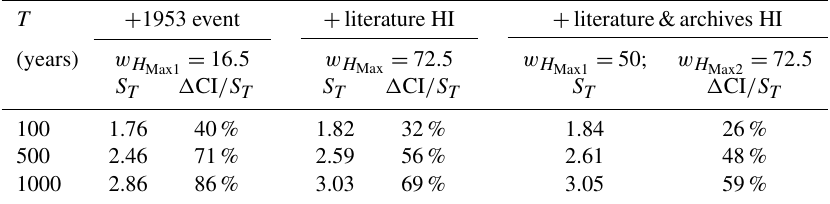
Table 6. The T -year quantiles and relative widths of their 70%CI (all of the durations are given in years). T + 1953 event + literature HI + literature&archives HI = 16 . 5 w H = 72 . 5 w H = 50; (years) w H Max Max1 Max1 S T (cid:49) CI /S T S T (cid:49) CI /S